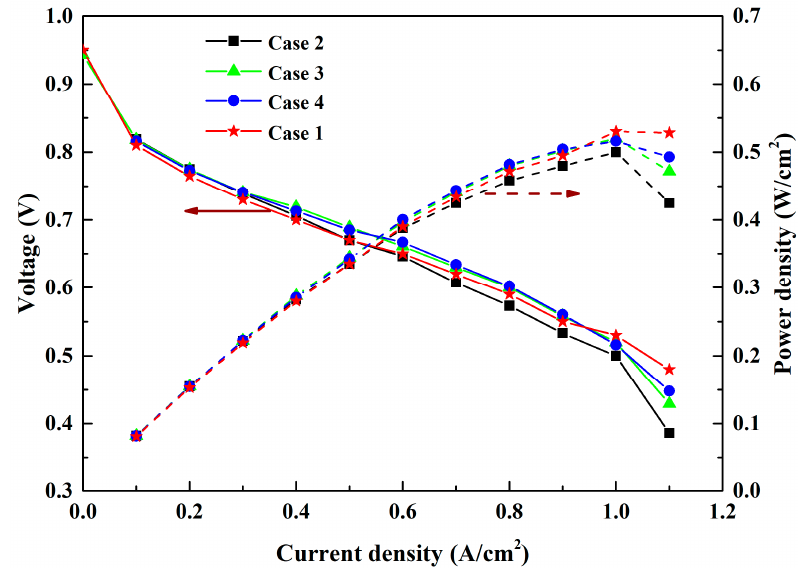
Figure 4. Polarization curve and power density in various RHa cases.